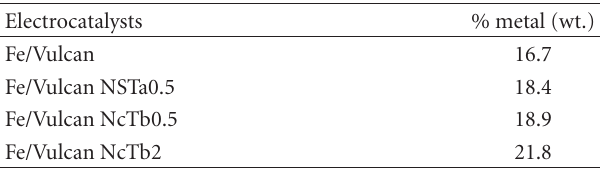
Table 4: Metal load of the carbon-supported Fe electrocatalysts. Electrocatalysts